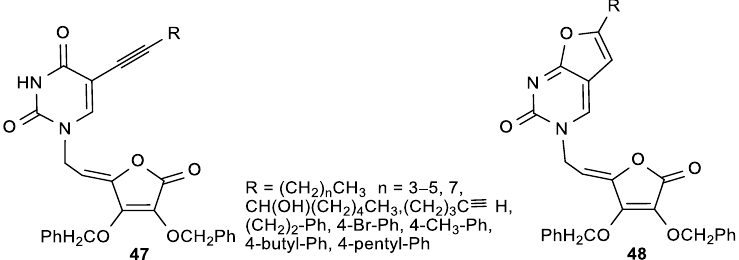
Figure 21. The C-5 substituted pyrimidine and 6-alkylfuro [2,3- d ] pyrimidine-4,5-didehydro- L -ASA derivatives. Table 19. The cytostatic activities of C-5 substituted pyrimidine and 6-alkylfuro[2–3- d ]pyrimidine-4,5-didehydro- L -ASA derivatives. Comp.